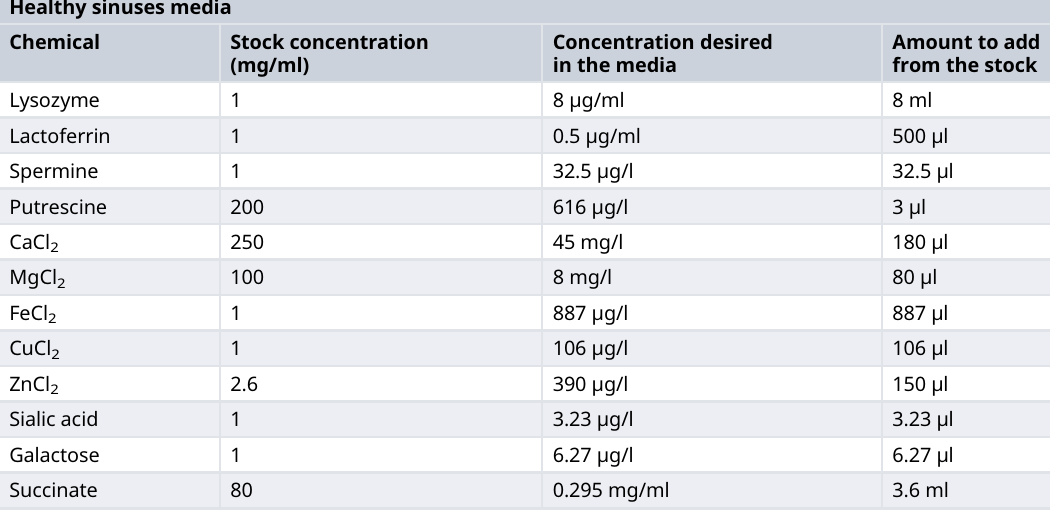
Table 10. Volumes of each chemical to add into the base media for 1 litre HSLM. Healthy sinuses